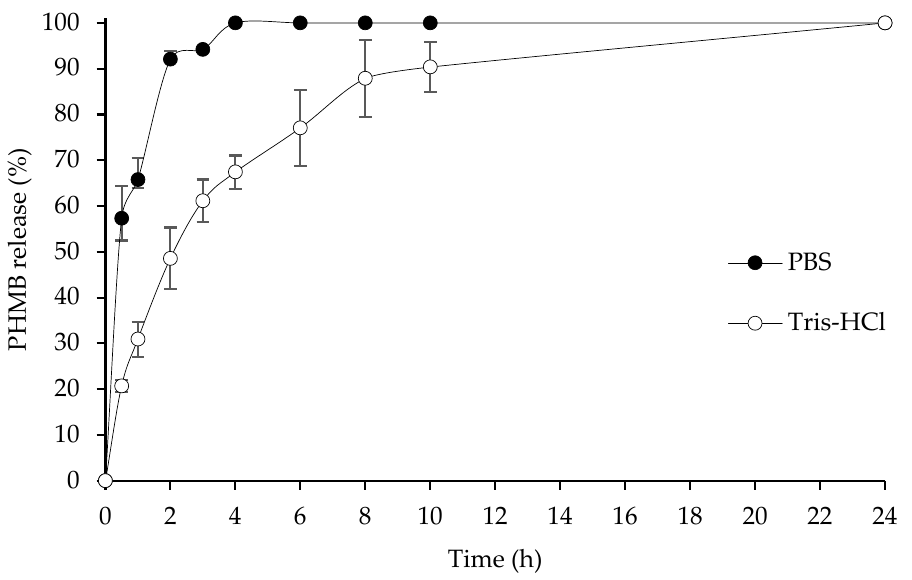
Figure 4. PHMB release profile from BC/A-PHMB hydrogel in PBS and Tris-HCl buffer pH 7.4. Table 5. BC/A-PHMB released kinetic profile in various drug release models.